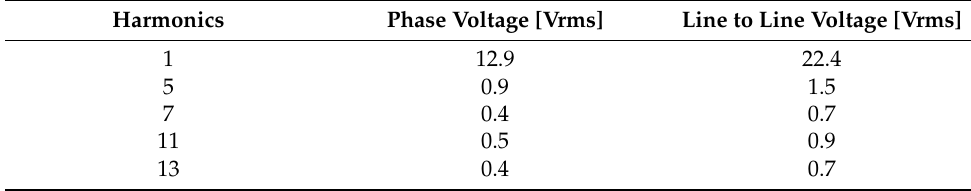
Figure 7. BEMF calculation at 480 r/min using FEM. ( a ) Voltage curves; ( b ) FFT analysis. Table 4. BEMF values by